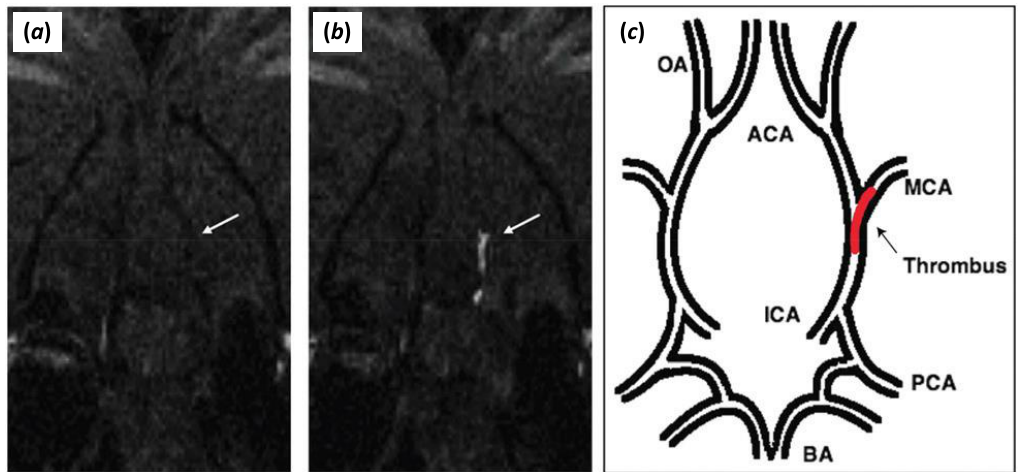
Figure 5. Coronal slice from middle cerebral artery 3D T1-weighted MR images of the detection of an intracranial thrombus (white arrow) in a rat ischemic stroke model using EP-2104R : ( a ) pre-contrast image; ( b ) post-contrast after injection of EP-2104R with clear detection of the thrombus (arrow) located in branch of the internal carotid artery (ICA) with the MCA; ( c ) schematic representation of the thrombus within the cerebral arterial tree, where BA = basilar artery, PCA = posterior cerebral artery, ICA = internal carotid artery, OA = olfactory artery and ACA = anterior cerebral artery. Reproduced with permission of The Royal Society of Chemistry from Ref. [37] (Copyright 2017